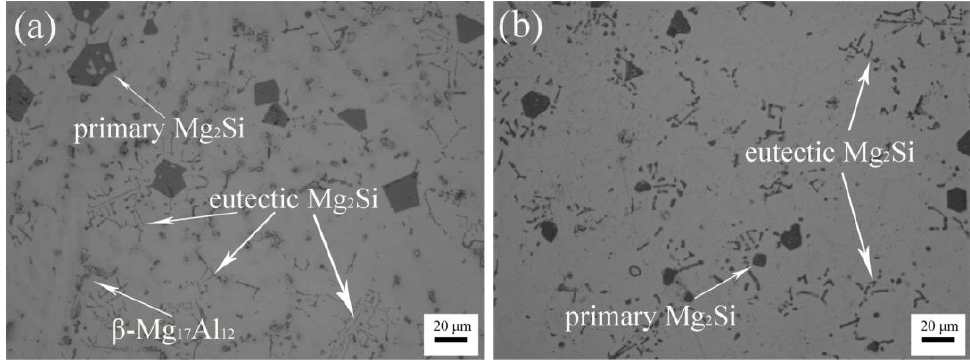
Figure 3. Optical microstructure of the as-cast composites ( a ); and solution-treated composites ( b ).